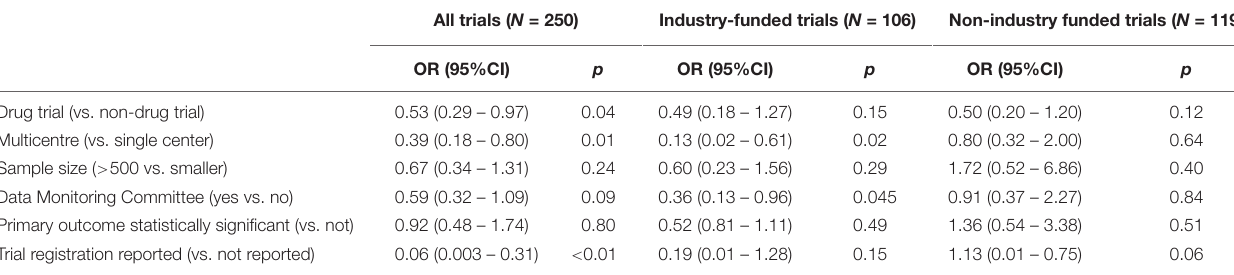
TABLE 3 | Multivariable regression analyses for all included trials, and trials with and without stated funding from the industry*. All trials ( N = 250)